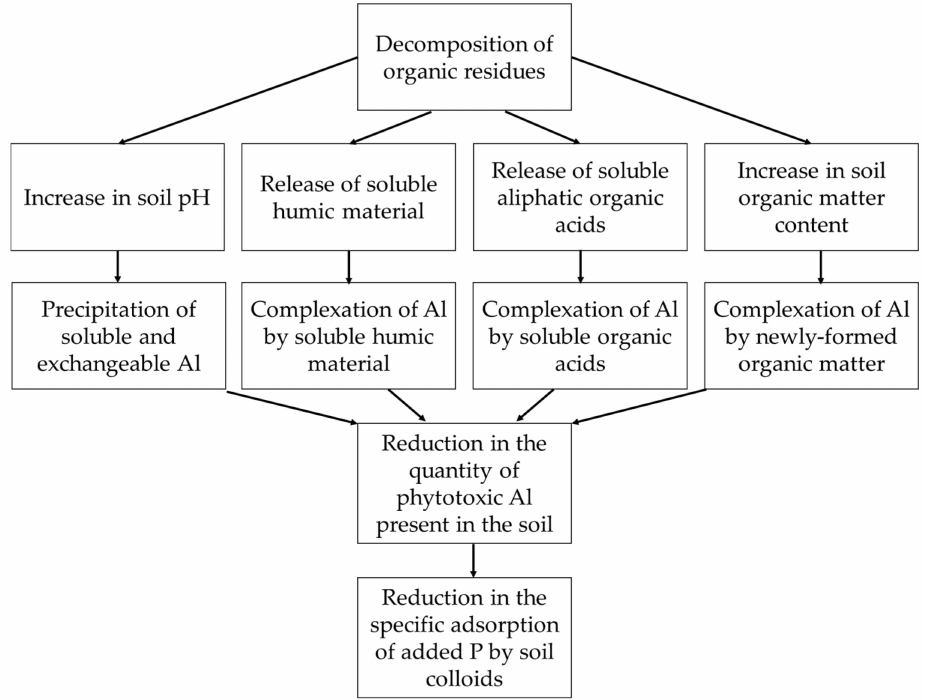
Figure 6. A conceptual model of major processes that lead to a reduction in the phytotoxic aluminium present in the soil and the increased phosphorus availability when organic amendments are added to the soil